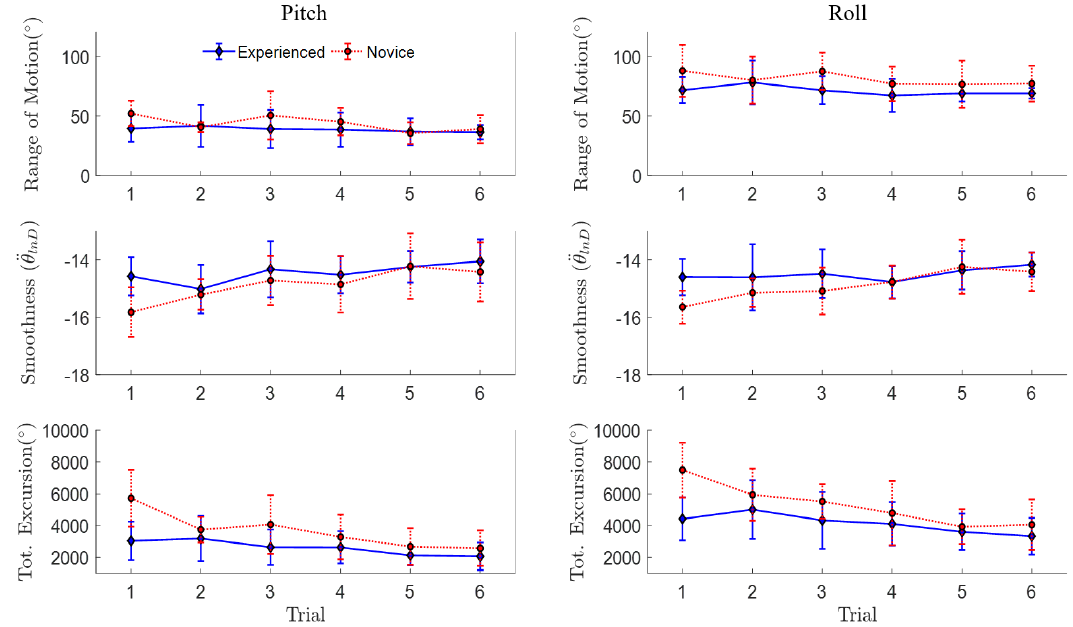
Figure 6. Mean ± SD quality of movement IMU-based metrics across six repeated trials including pitch and roll active range of motion ( ◦ ), smoothness (¨ θ lnD ), and total angular excursion (Tot. Excursion: θ Tot ( ◦ )) separated by video-game experience (experienced, novice).